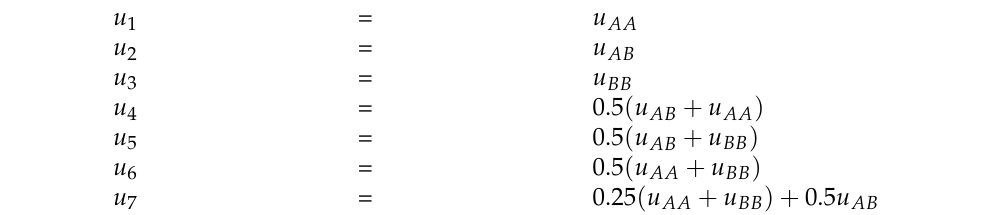
Table 1. Different possible values of the nearest neighbor interaction